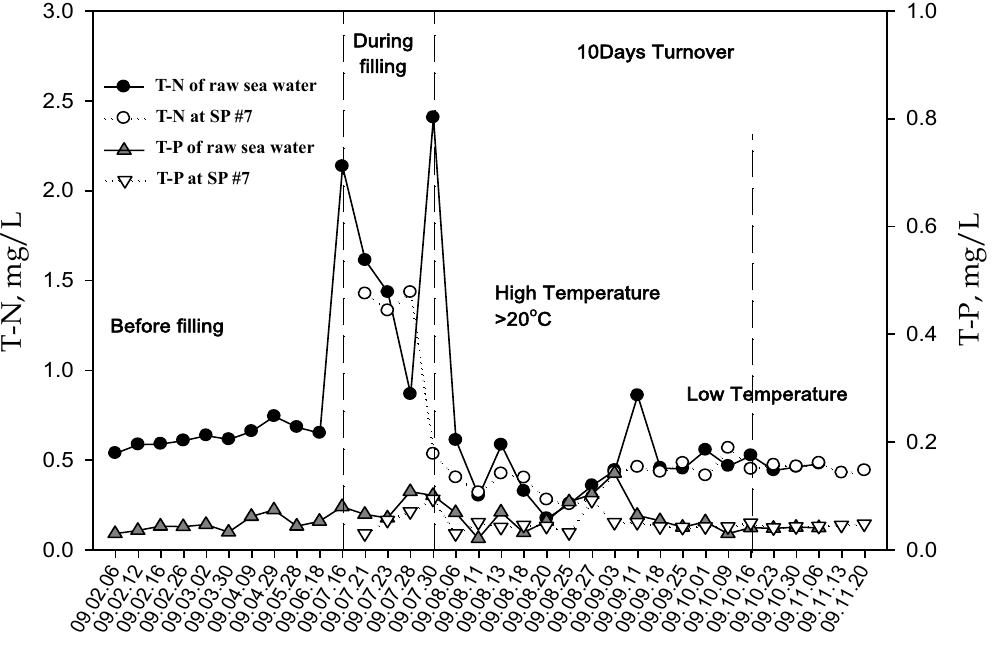
Figure 4. Nutrient variations in the canal within a 10-day